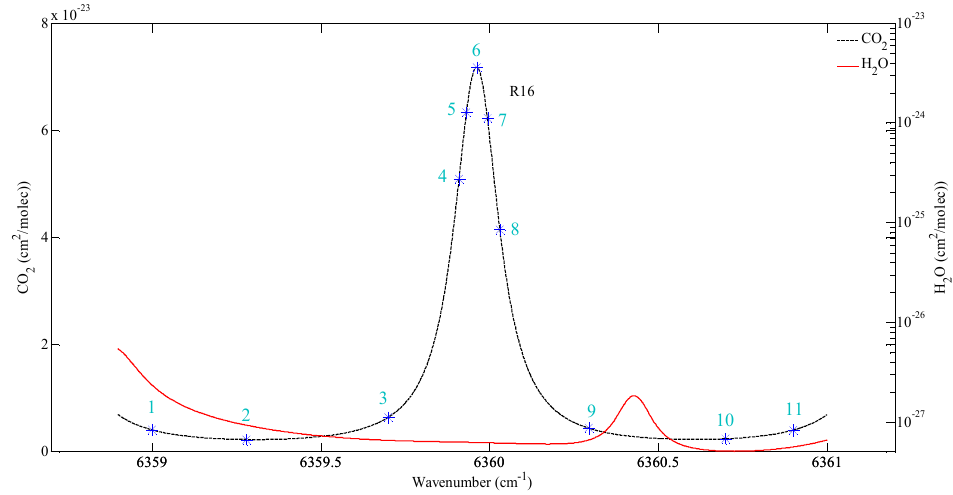
Figure 4. Selections of the multiple wavelengths in the region of R16 for the MW-DIAL. The black dotted and red lines are the absorption lines of CO 2 and H 2 O, respectively.